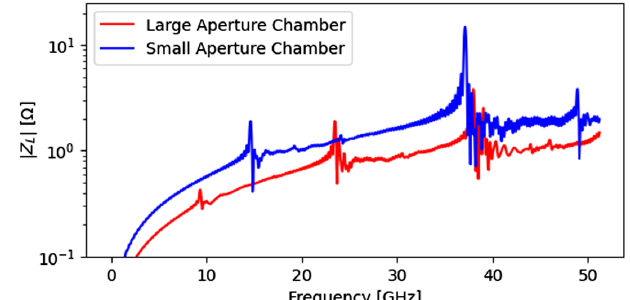
FIG. 7. Longitudinal impedance from a σ z ¼ 2 mm Gaussian beam and a block defect of h d ¼ 0 . 3 mm and L d ¼ 2 . 5 mm for small and large aperture vacuum